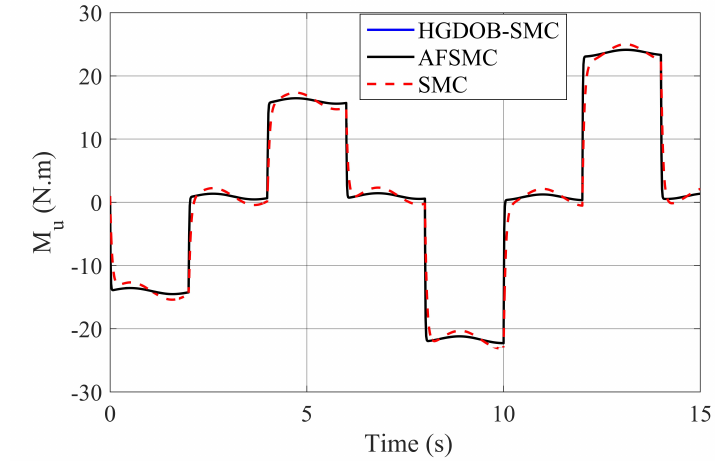
Figure 12. Control signal M u .